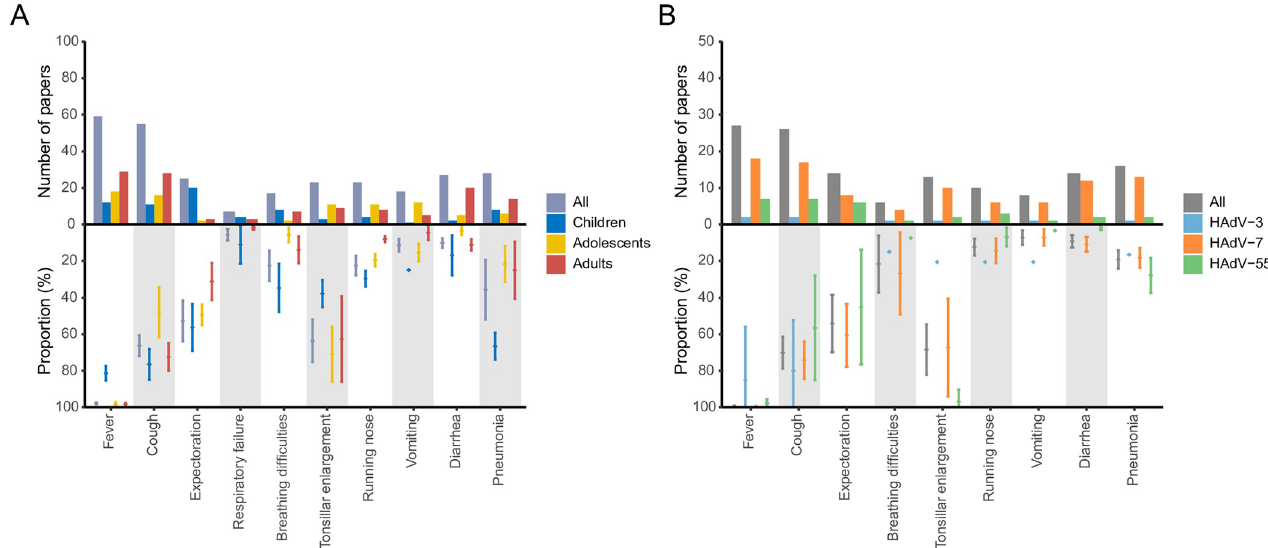
Fig 5. Clinical manifestations of HAdV infection by age groups and virus types. (A) for different age groups; (B) for different virus types. The bars indicate the number of articles, and the intervals indicate the proportion of patients with the clinical manifestation and 95% CI based on the meta-analysis.